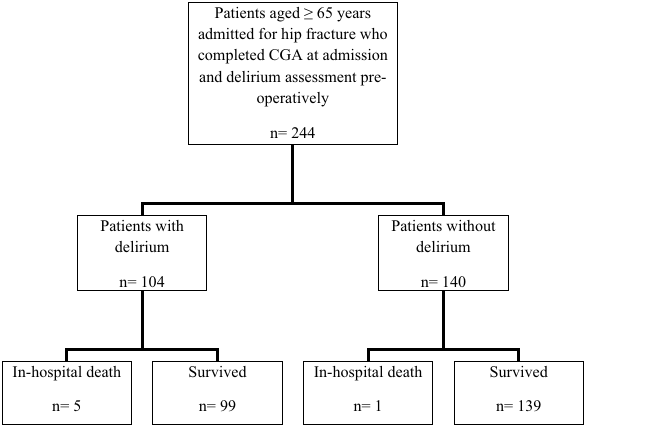
Figure 1. Retrospective cohort study